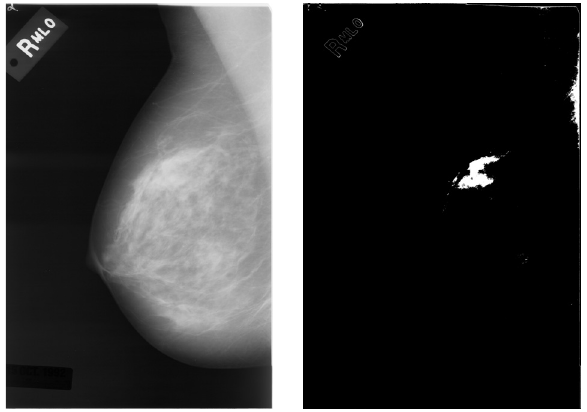
Figure 15. Mammogram with PCNN Identified